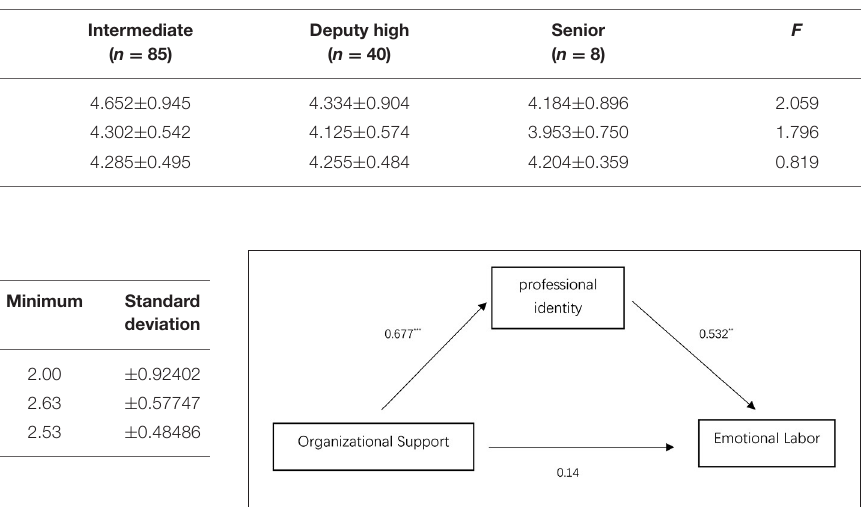
TABLE 4 | Results of the one-way analysis of variance based on professional title.